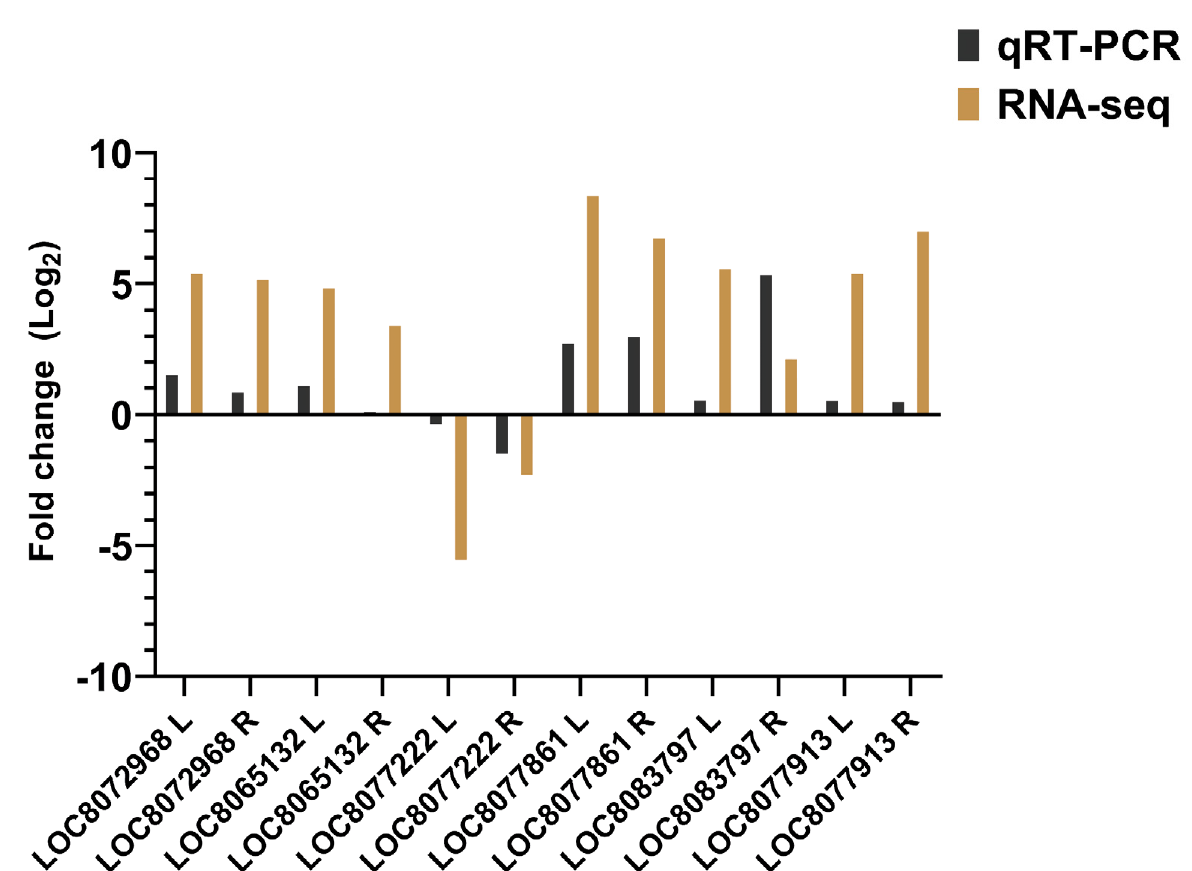
Figure 6. Comparison of the expression patterns of the six genes between the qRT-PCR and RNAseq results. For fold change, gene expressions between the two sorghum genotypes were obtained from the leaves and roots, respectively, under salt stress. The y -axis represents the relative expression level of a gene in fold change (Log 2 ). The x -axis represents the gene accession. L, leaf; R, root. Fold change (Log 2 ) represents the expression level of Nampungchal compared to Sodamchal, which was upregulated when it was greater than 0 and downregulated when it was less than 0. If the expression direction (up or down) of the two data is the same, it indicates that there is a correlation with each other.